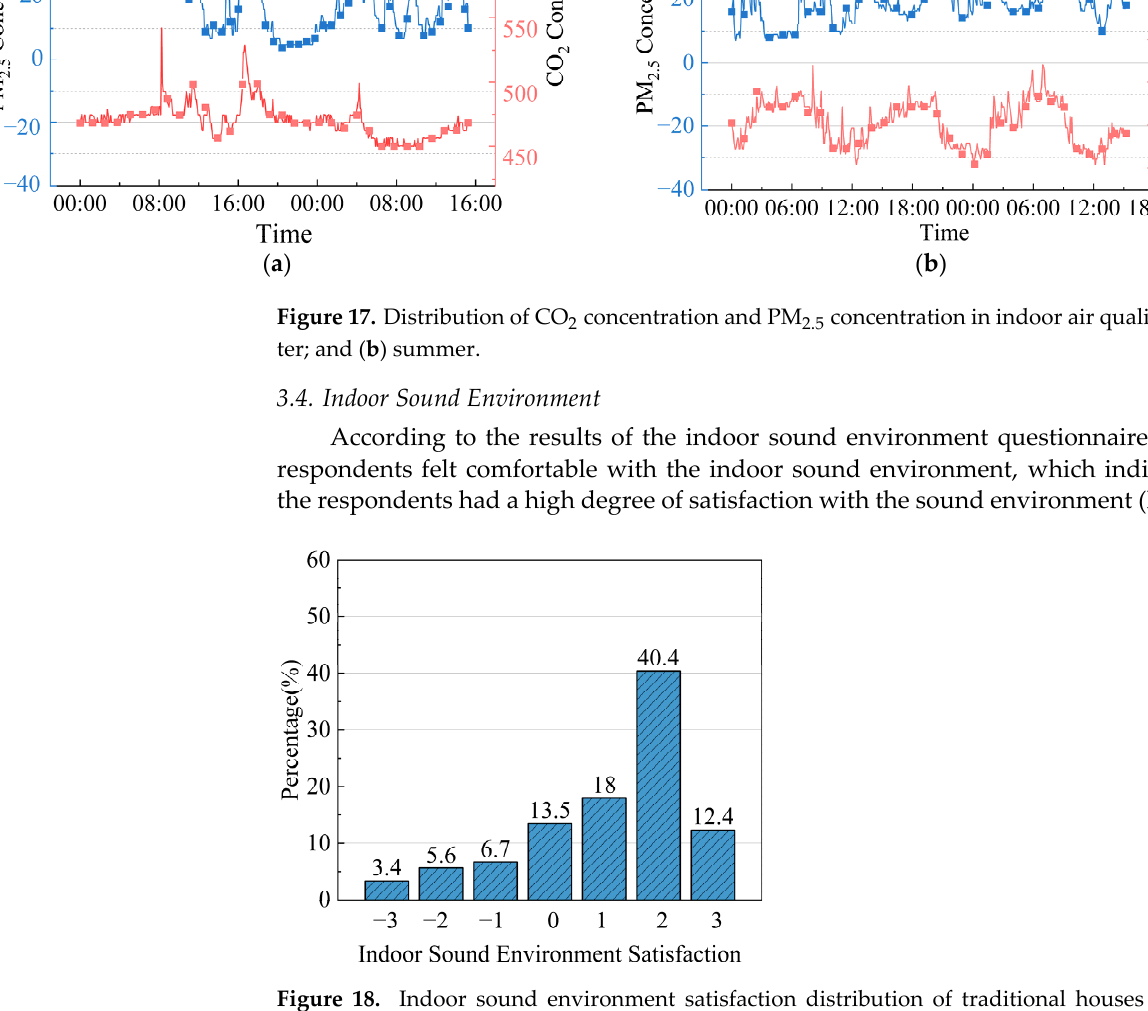
Figure 18. Indoor sound environment satisfaction distribution of traditional houses in Xixinan Vil- lage.